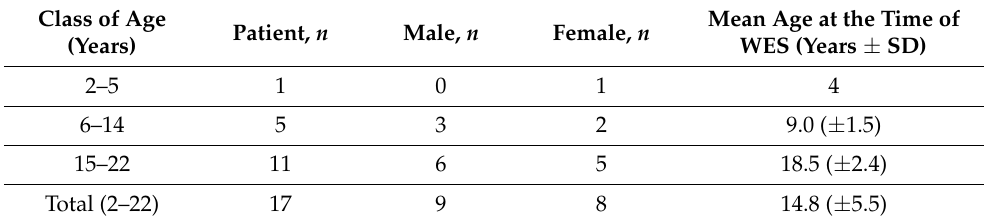
Table 1. Characteristics of patients having whole-exome sequencing (WES).